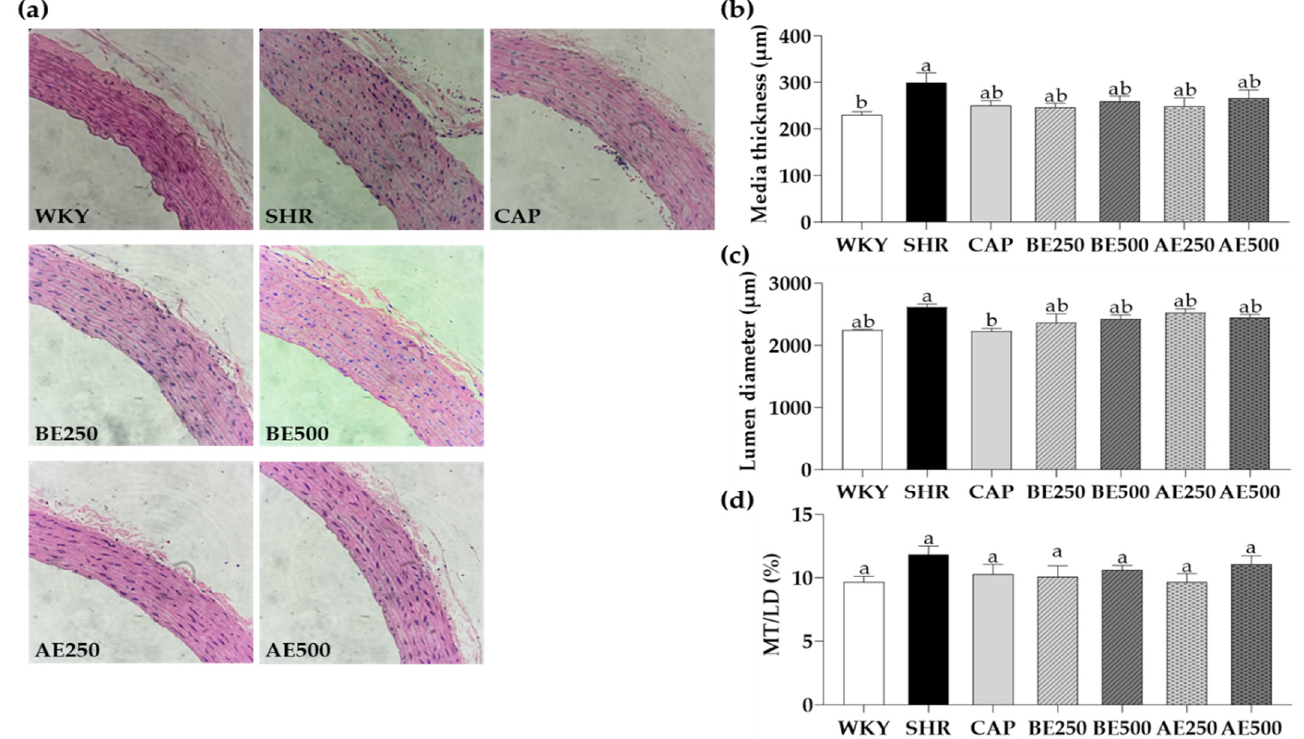
Figure 3. Histological findings with ( a ) H&E staining of aorta, ( b ) media thickness (MT), ( c ) lumen diameter (LD), and ( d ) MT/LD of aorta in the rat administered with black soybean or adzuki bean extracts for 8 weeks. Data are expressed as mean ± SEM. The values with different letters indicate significant differences at p < 0.05. WKY: Wistar-Kyoto rats, SHR: Spontaneously hypertensive rats, CAP: 50 mg/kg body weight (bw) of captopril, BE250: 250 mg/kg bw of black soybean extracts, BE500: 500 mg/kg bw of black soybean extracts, AE250: 250 mg/kg bw of adzuki bean extracts, AE500: 500 mg/kg bw of adzuki bean extracts.